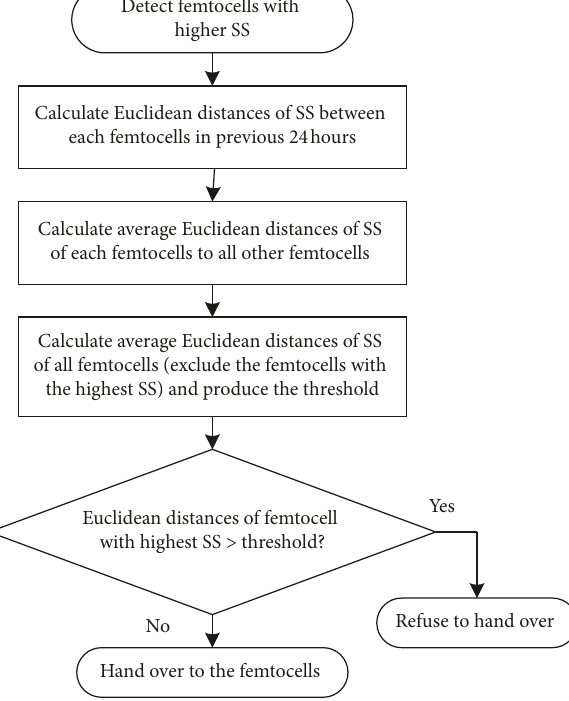
Figure 4: Flowchart to detect a rogue femtocell.